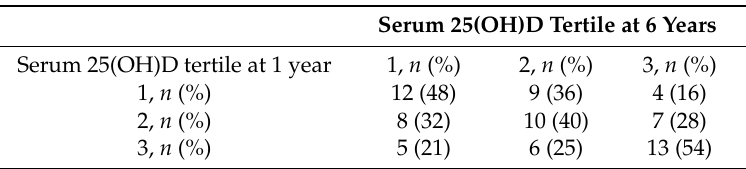
Table 4. Numbers of children with vitamin D status measured at two time points falling in different vitamin D tertiles at 1 and 6 years of age ( n =